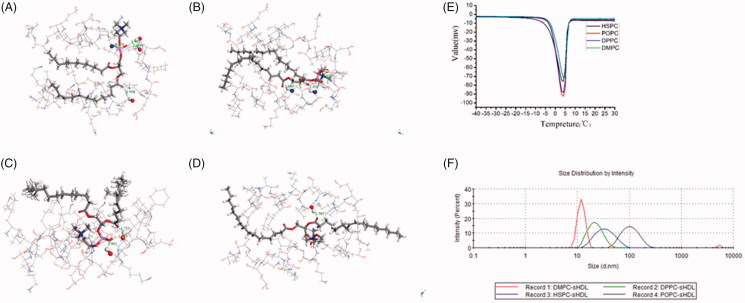
The molecular dynamic analysis models of mimetic peptid and (A) DMPC, (B) DPPC, (C) HSPC, and (D) POPC, respectively. (E) DSC curves of the four blank sHDL nanoparticles. (F) The DLS of sHDL nanoparticles.